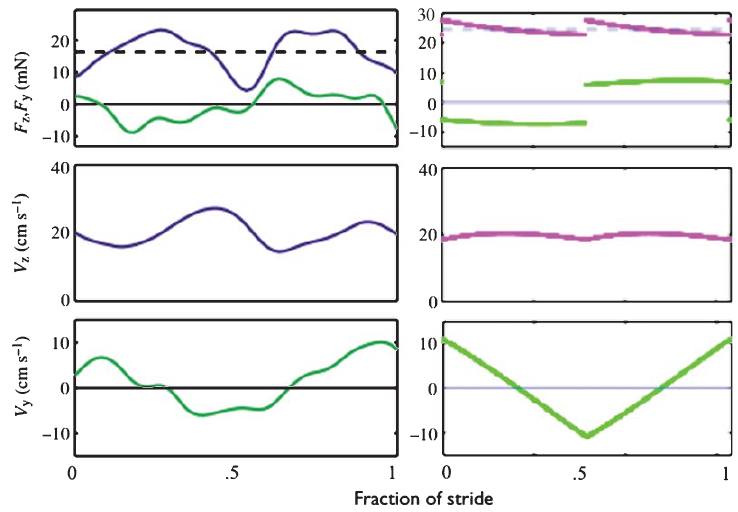
Fig.5. Cockroachforceandvelocityontheleft,world-switchedtemplatesimulationontheright.Dottedlinesrepresentbodyweight.Cockroach data taken from [2]. Note that while our template does not include a spring in series with the actuator, resulting in discontinuous force transitions, it climbs with similar velocity magnitude and phasing when compared to an actual cockroach.